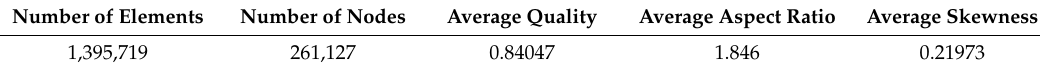
Figure 2. Fluid domain. Figure 2 . Fluid domain. Table 1 . Main mesh parameters. Table 1. Main mesh parameters.